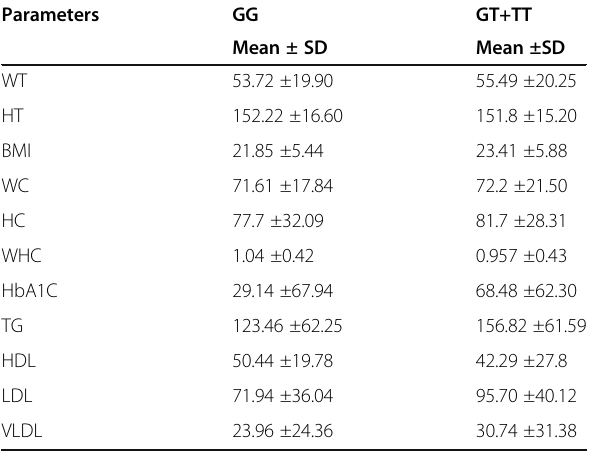
Table 2 clinical and anthropometric characteristics of study patients Parameters